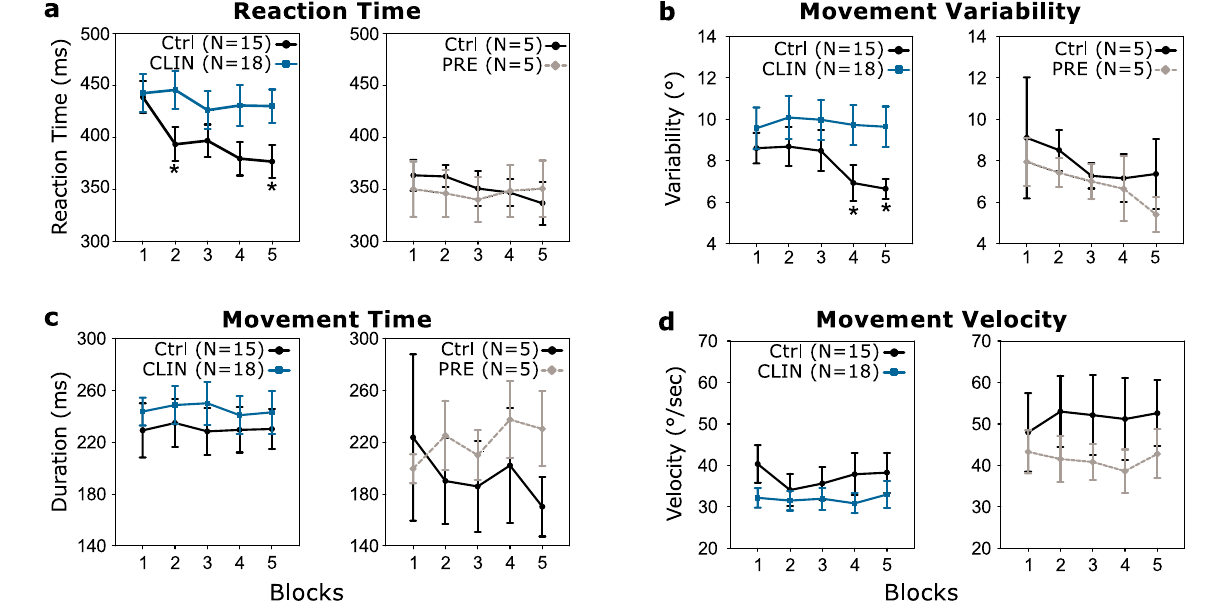
Figure 2. Movement kinematics in baseline. Movement reaction time ( a ), variability ( b ), time ( c ) and velocity ( d ) are shown for the 5 baseline blocks (average across 10 trials) for the CLIN patients (blue squares and lines), the PRE participants (grey diamonds and dashed lines) and their respective age-matched controls (Ctrl: black disks and lines). Error bars are standard errors of the mean. Statistical differences are represented as follows: * p < 0.05 (Significant ANOVAs followed by Bootstrap independent samples